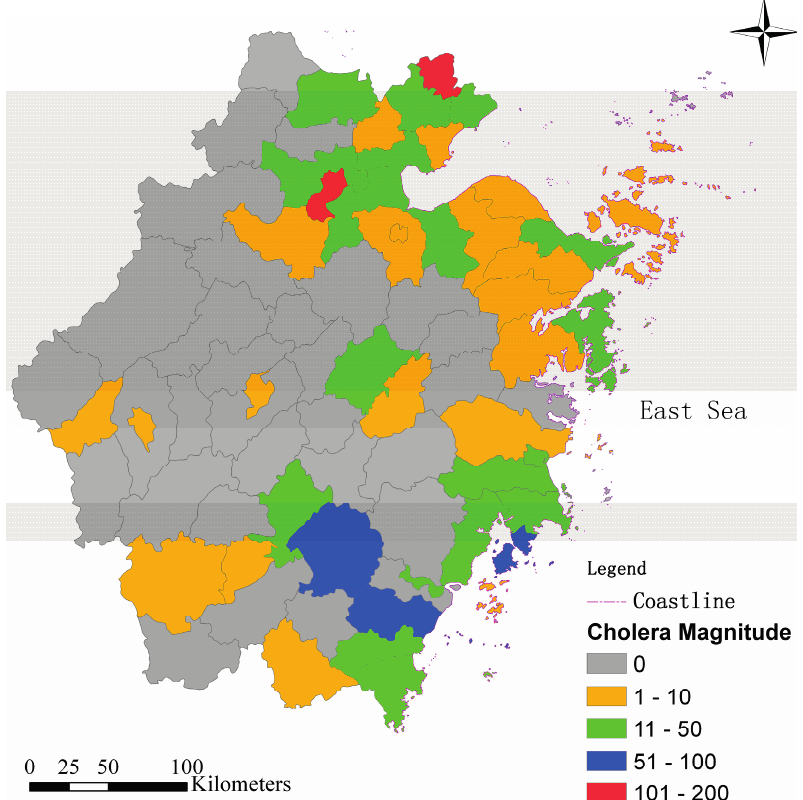
Figure 8. Spatial distribution of cholera magnitude in the study area during